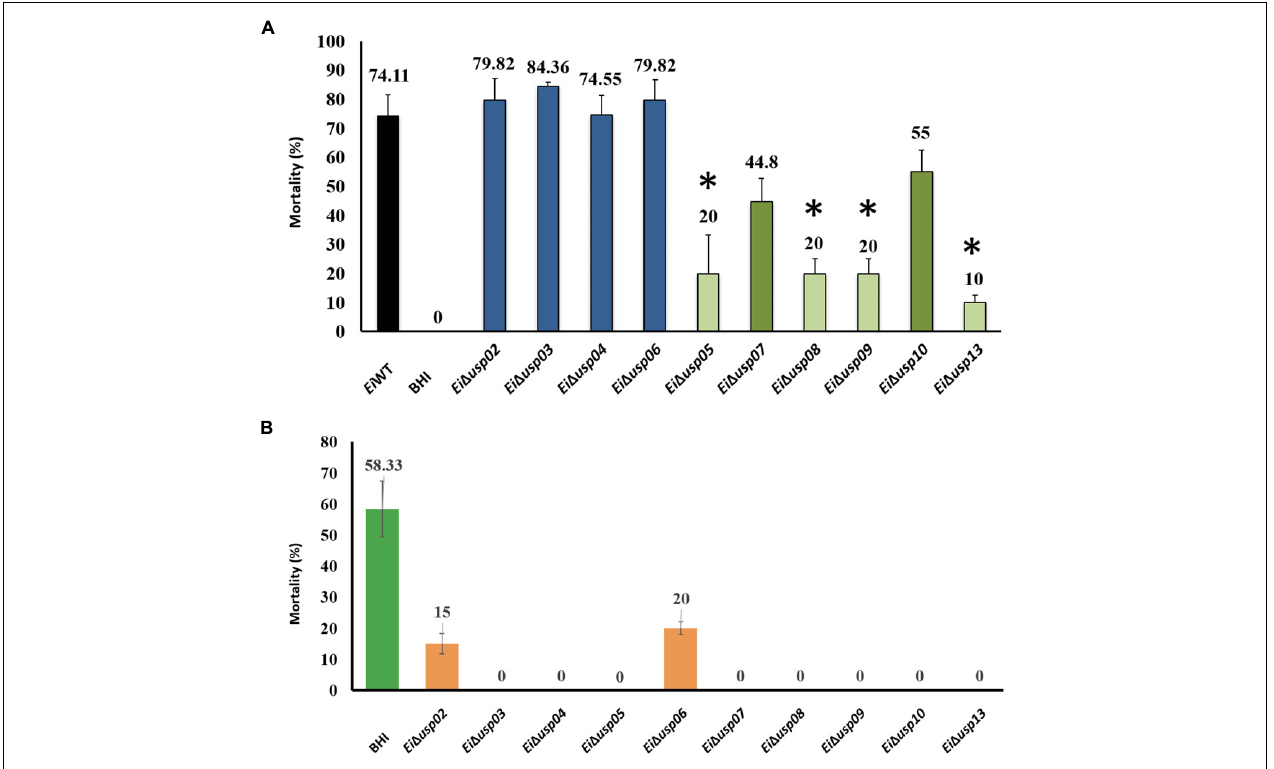
FIGURE 6 | Vaccination tests of USP mutants in channel catfish fingerlings. (A) Percent mortalities seen after vaccination. (B) Percent mortalities of channel catfish fingerlings immunized with USP mutants and re-challenged with E. ictaluri wild-type 3 weeks post immunization. ∗ indicates significant differences between mutant and WT at P <